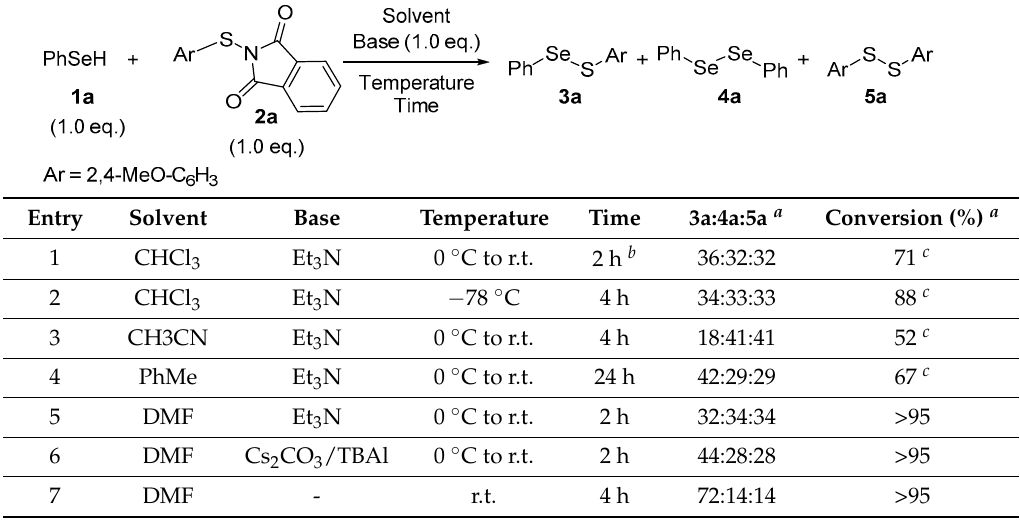
Table 1. Optimization of the reaction conditions for the synthesis of 3a from 1a and 2a .